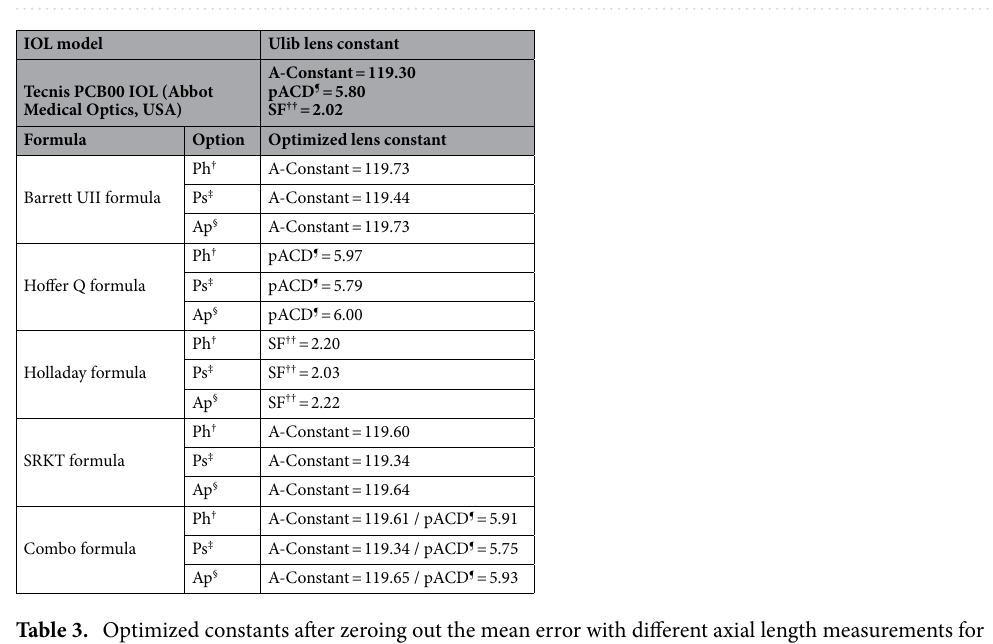
Table 3. Optimized constants after zeroing out the mean error with different axial length measurements for each formula. † Preoperative axial length, phakic option; ‡ postoperative axial length, pseudophakic